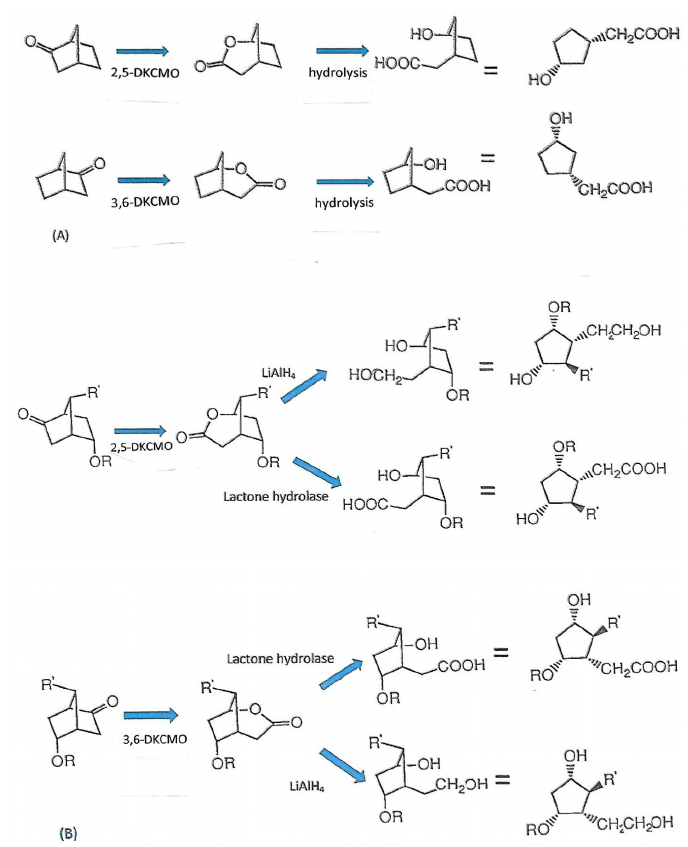
Figure 6. Generation of enantiocomplementary substituted cyclopentanes with multiple chiral centres by deploying DKCMO-catalysed biotransformations of either ( A ) unsubstituted (=2 chiral centres) or ( B ) bisubstituted (=4 chiral centres) bicyclo[2.2.1] ketones as a key